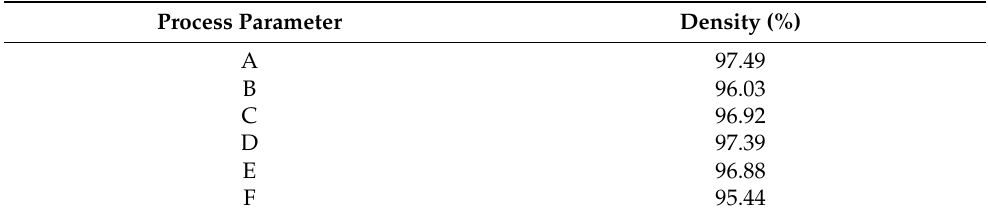
Figure 3. Light microscope images of the polished cross sections for the base alloy EN AW-5083 (AlMg4.5Mn0.7). ( A – F ) Process parameters are listed in Table 2 and correspond to the letter of each cross section. Furthermore, the results of the density measurements, which were done with image processing, are listed in Table 4. Table 4. Results of the density measurements of the EN AW-5083 specimens, done with image processing. The process parameters used are listed in Table 2.